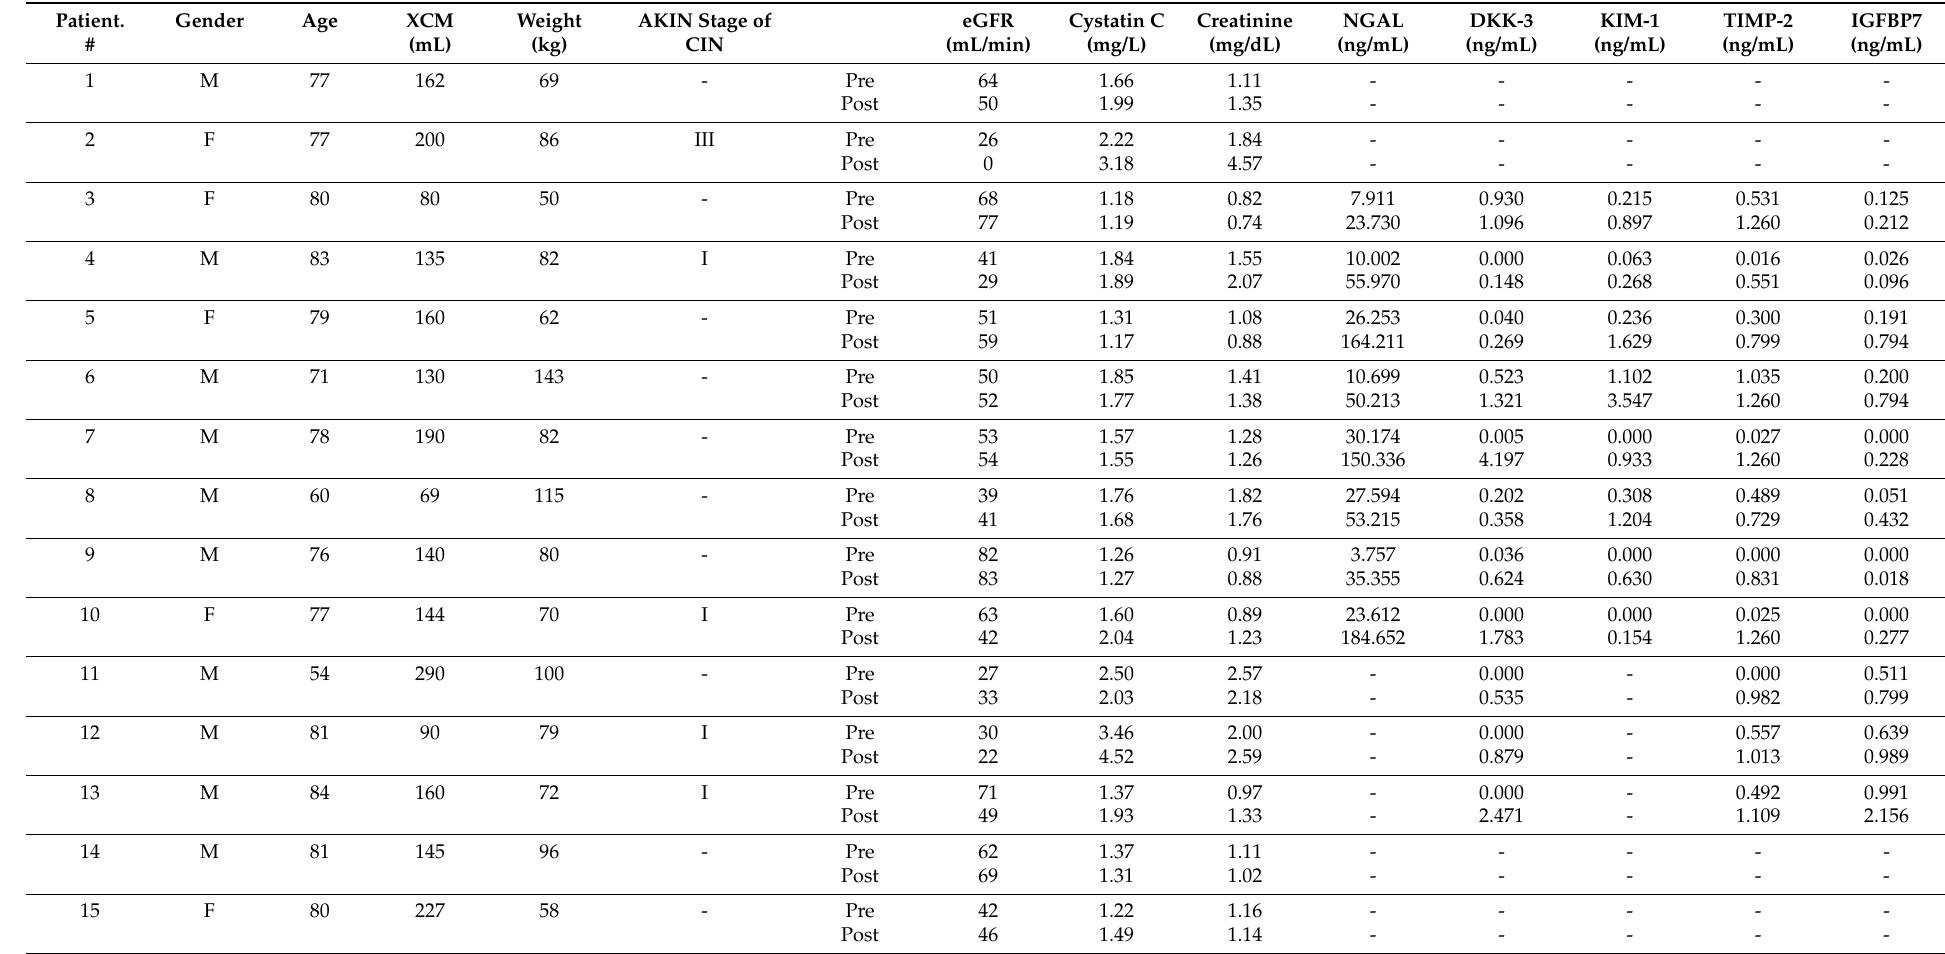
Table 1. Characteristics of all patients. Gender (female (F), male (M)), age, amount of radiographic contrast medium (XCM) applied (in mL), patients’ weight (in kg), and Acute-Kidney- Injury-Network (AKIN) stage of contrast-induced nephropathy (CIN) due to Kidney-Disease-Improving-Global-Outcomes (KDIGO) [1,17] are shown. Furthermore, clinical renal routine parameter eGFR (mL/min), creatinine (mg/dL), and cystatin C (mg/L) and advanced urinary injury markers, NGAL, DKK-3, KIM-1, TIMP-2, IGFBP-7 (ng/mL) before and at the time point of the strongest measured deviation (48–72 h) after interventional are displayed.